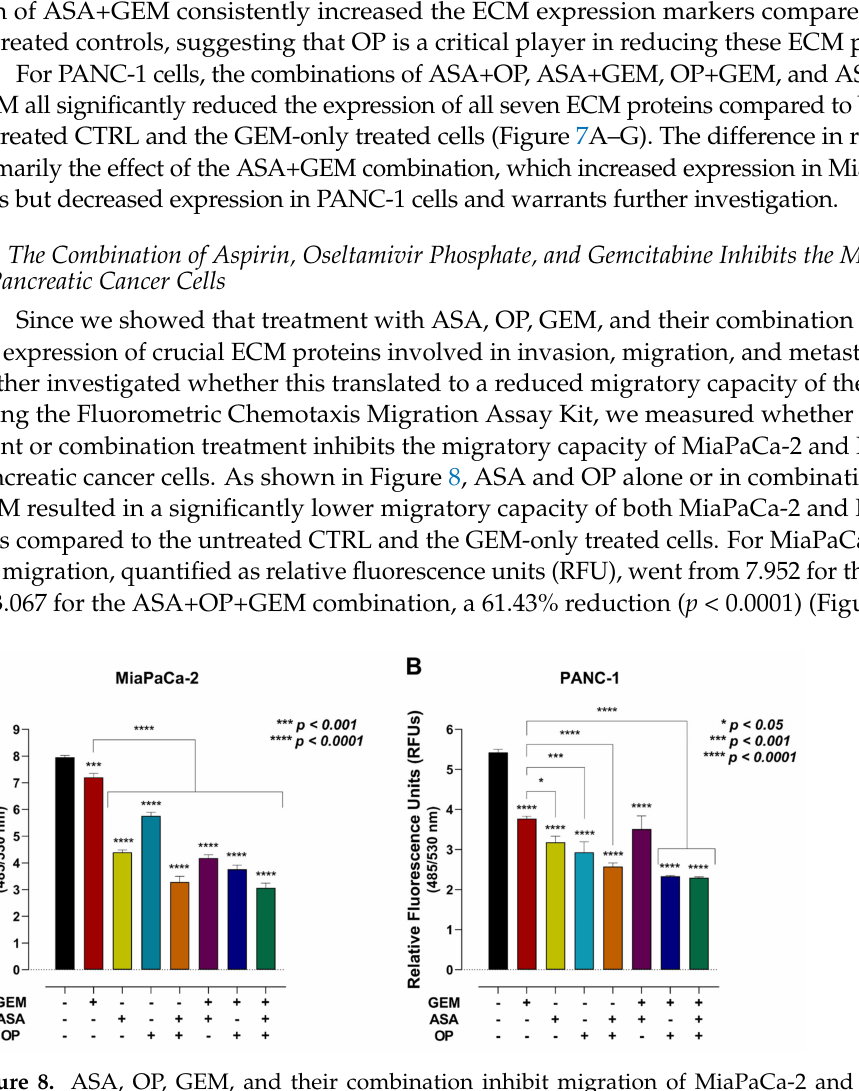
Figure 8. ASA, OP, GEM, and their combination inhibit migration of MiaPaCa-2 and PANC-1 pancreatic cancer cells. ( A ) MiaPaCa-2 cells were pre-treated with ASA (0.7 mM), OP (3.5 mM), GEM (0.285 µ M), or their combination, and ( B ) PANC-1 cells were pre-treated with ASA (4 mM), OP (4.7 mM), GEM (0.338 µ M), or their combination for 7 days. Treated cells were collected and resuspended in 1 × DMEM (no FBS), added into the migration chamber, and allowed to adhere for 4 h to allow for migration into the feeder tray containing 10% FBS. Unbound cells were removed, and the migration insert plate was transferred onto a new cell culture tray with the cell detachment solution. Cells were incubated for 30 min, and the CyQuant GR dye in lysis buffer was added to the wells and incubated for 15 min. The mixture was transferred to a 96-well plate and read with a fluorescence plate reader. The data are presented as relative fluorescence units (RFUs) (ex 485; em 530) ± SEM of 3 independent experiments performed in triplicates. Significance is shown compared to the CTRL unless otherwise shown. Abbreviations: ASA, aspirin; OP, oseltamivir phosphate; GEM, gemcitabine; FBS, fetal bovine serum; RFU, relative fluorescence unit; SEM, standard error of the mean; CTRL,